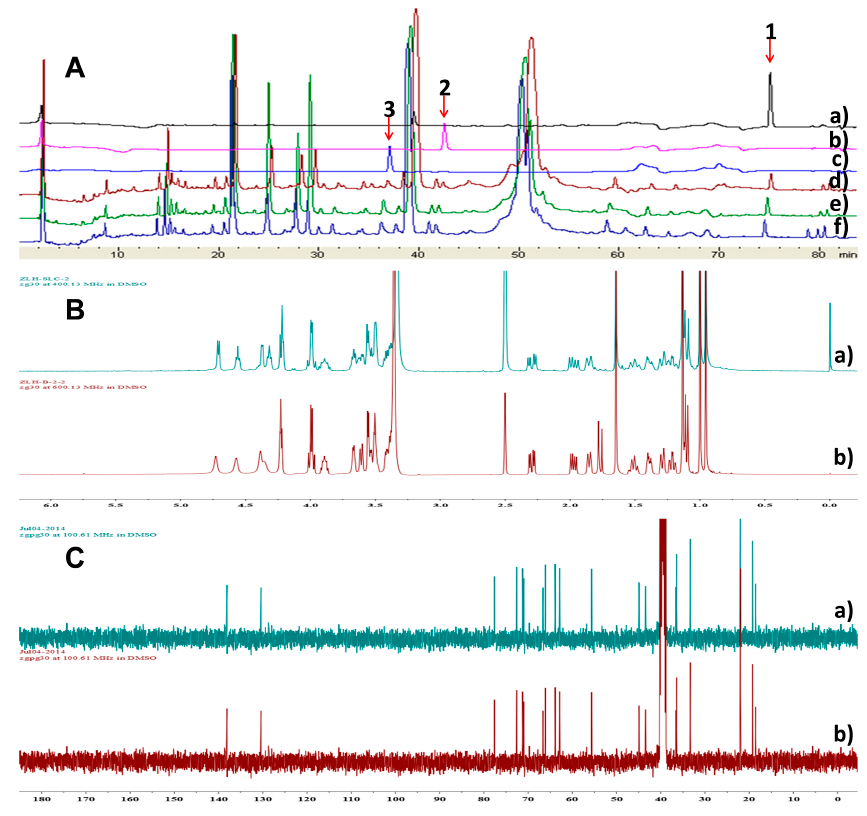
Figure 7. Analysis of the reference compounds 1 – 3 and metabolites of P. sporulosum YK-03 in different mediums using HPLC and NMR methods. ( A ) HPLC Analysis of the reference compounds 1 – 3 and metabolites of P. sporulosum YK-03 in different mediums: (a) compound 1 ; (b) compound 2 ; (c) compound 3 ; (d) metabolites from blank group (medium with-No mannitol); (e) metabolites from control group (Normal medium, mannitol-contained medium); (f) metabolites from experimental group (medium with mannitol replaced by sorbitol); 1 H-NMR ( B ) and 13 C-NMR ( C ) spectra of compound 2 isolated from the experimental and control groups: (a) experimental group; (b) control